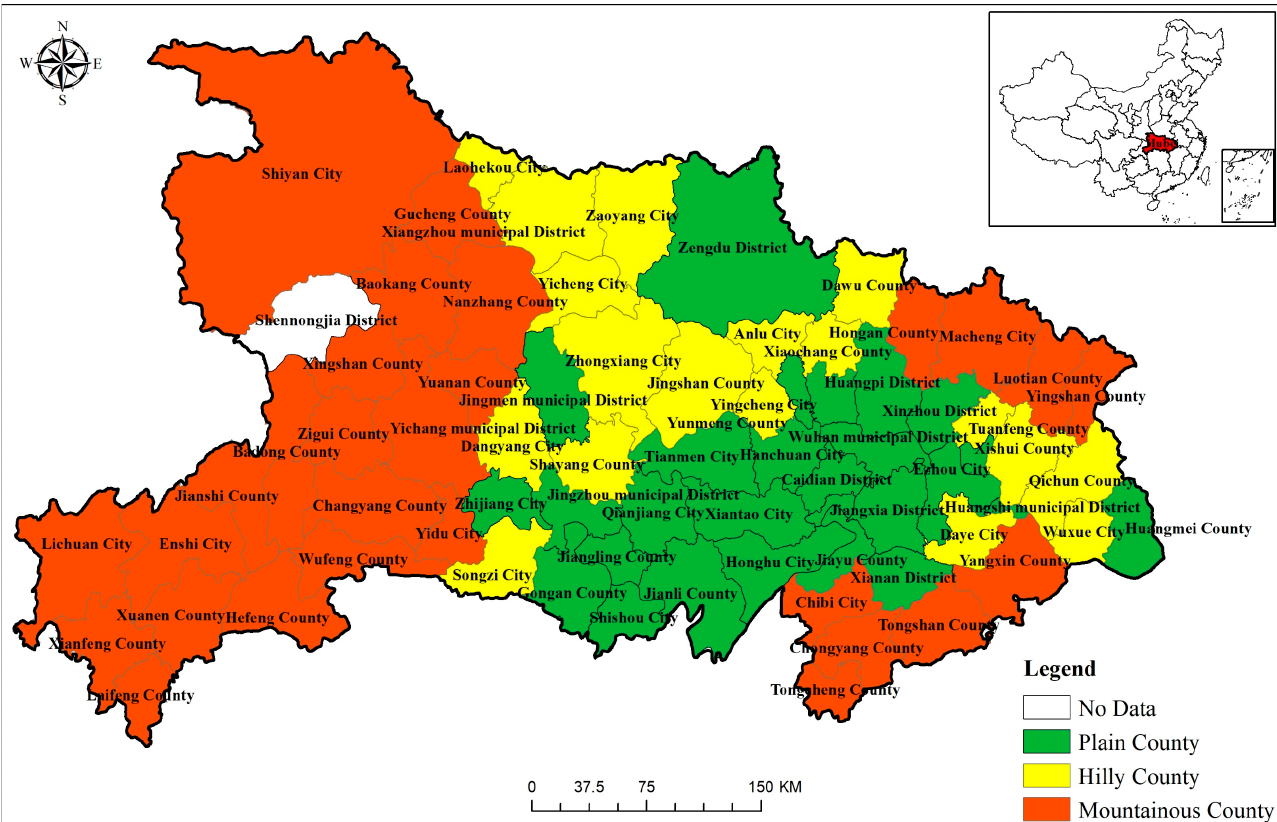
Figure 1. Location of study area and county type division.